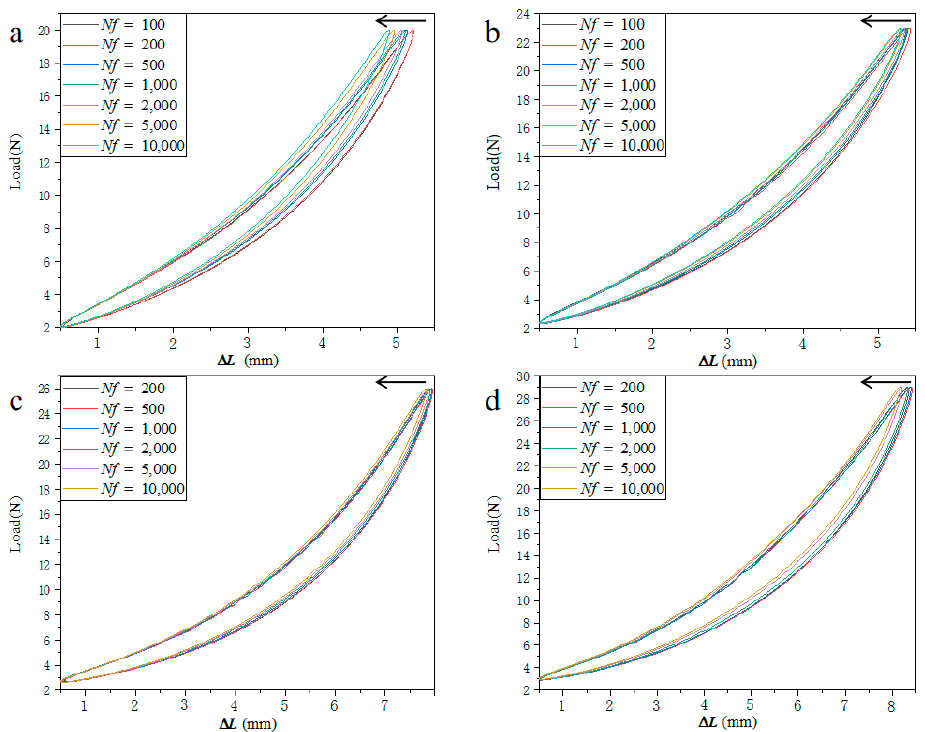
Figure 7. Hysteresis loop at different stress of ( a ) 13.08 MPa, ( b ) 15.72 MPa, ( c ) 17.80 MPa, and ( d ) 20.35 MPa.